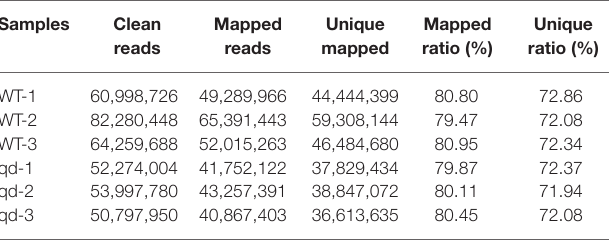
TABLE 1 | Comparison of clean reads and the reference genome.